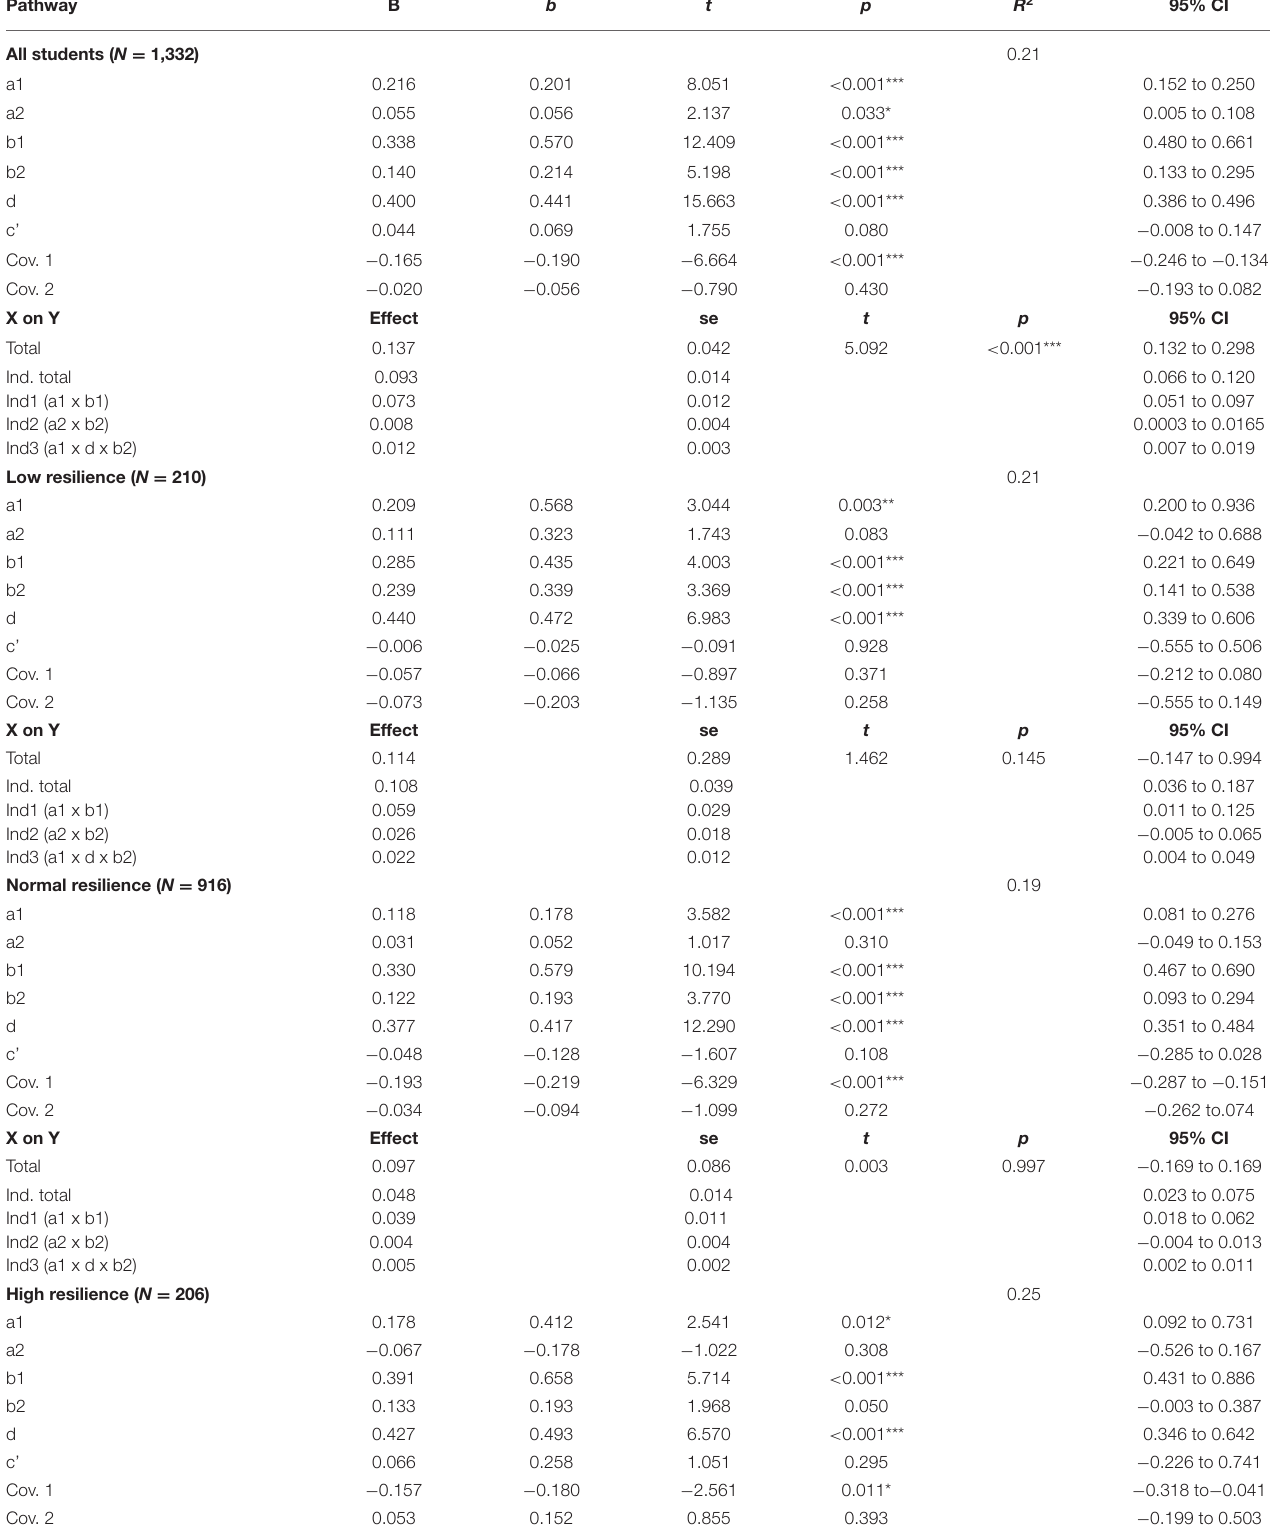
TABLE 4 | Standardized (B) and unstandardised (b) regression coefficients, and significance tests for the explanatory model pathways between the HE student group and resilience groups.